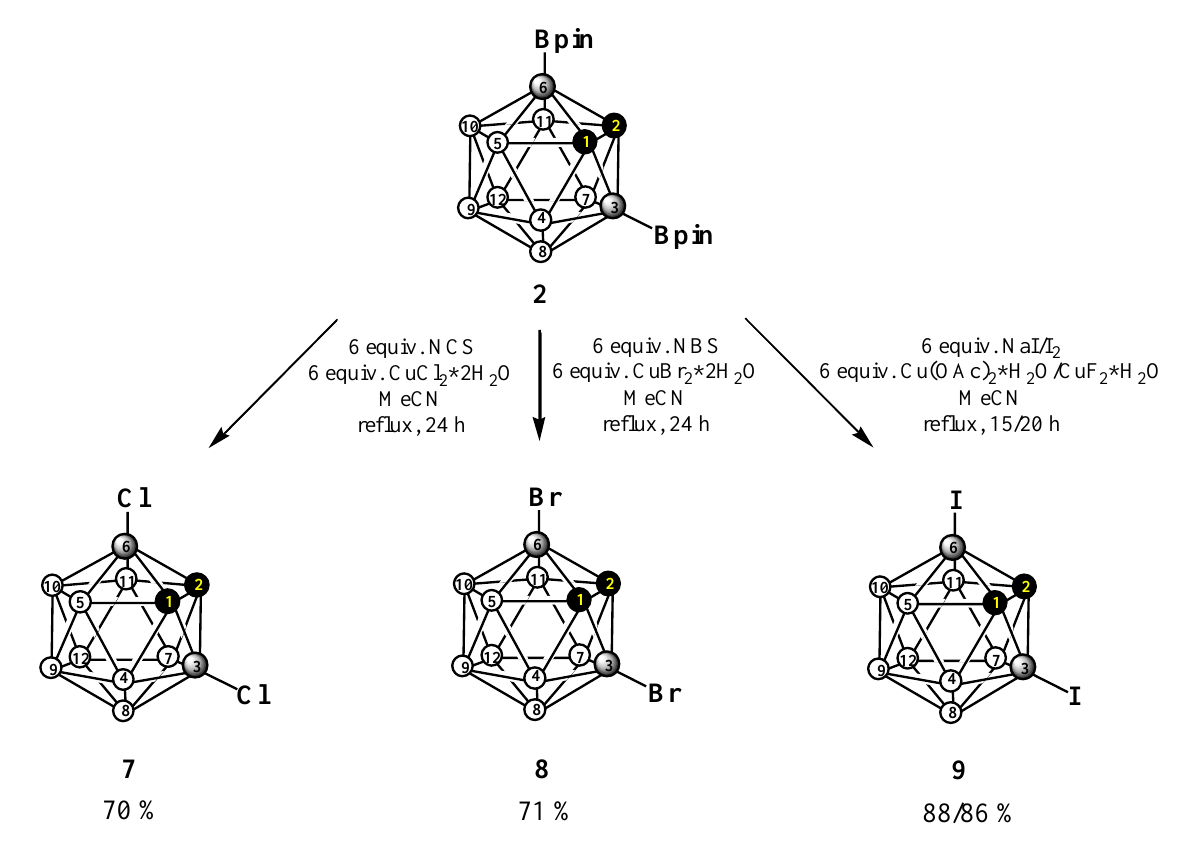
(3.65 Å) [82]) linked molecules into chains along the (101) direction while all the other interactions were Van der Waals (Figure 2).